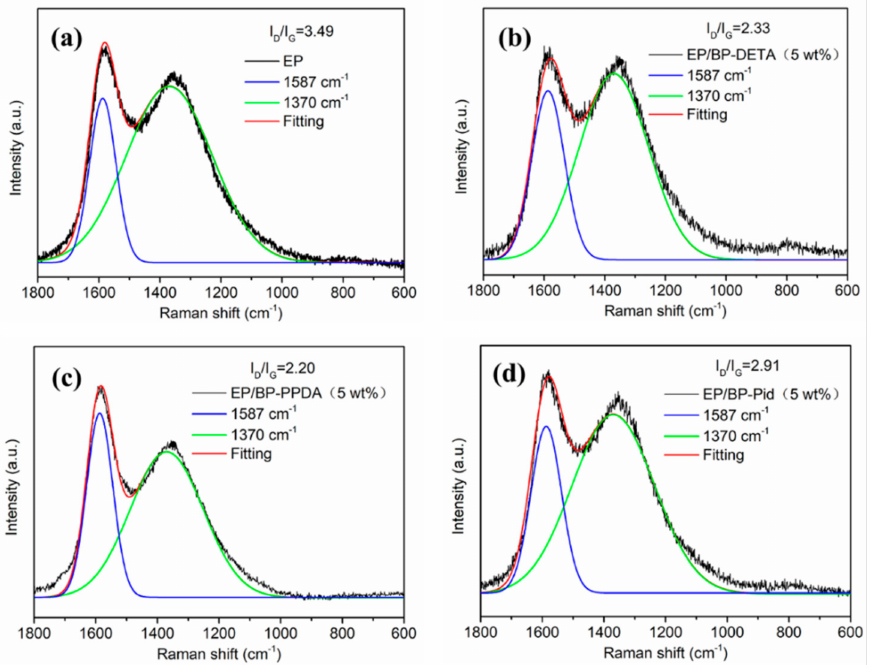
Figure 9. Raman spectra of the char residues of ( a ) pure EP, ( b ) EP/BP-DETA (5 wt%), ( c ) EP/BP- PPDA (5 wt%) and ( d ) EP/BP-Pid (5